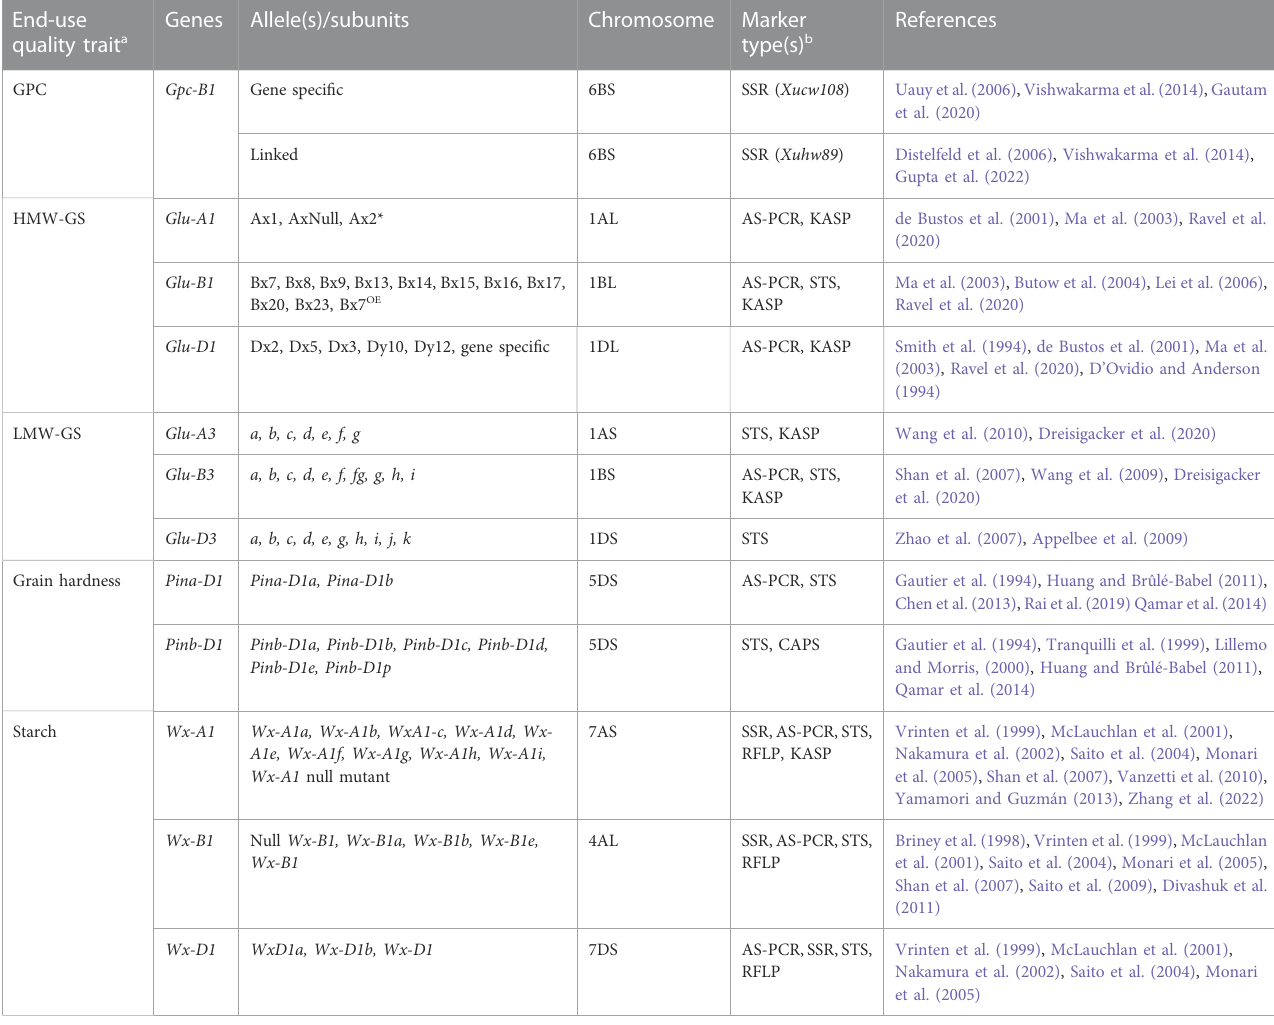
a GPC, grain protein content; HMW-GS, high molecular weight-glutenin subunit; LMW-GS, low molecular weight-glutenin subunit. b STS, sequence-tagged site; CAPS, cleaved ampli fi ed polymorphic sequences; AS-PCR, allele speci fi c-polymerase chain reaction; RFLP, restriction fragment length polymorphism; SSR, simple sequence repeat; KASP, kompetitive allele speci fi c